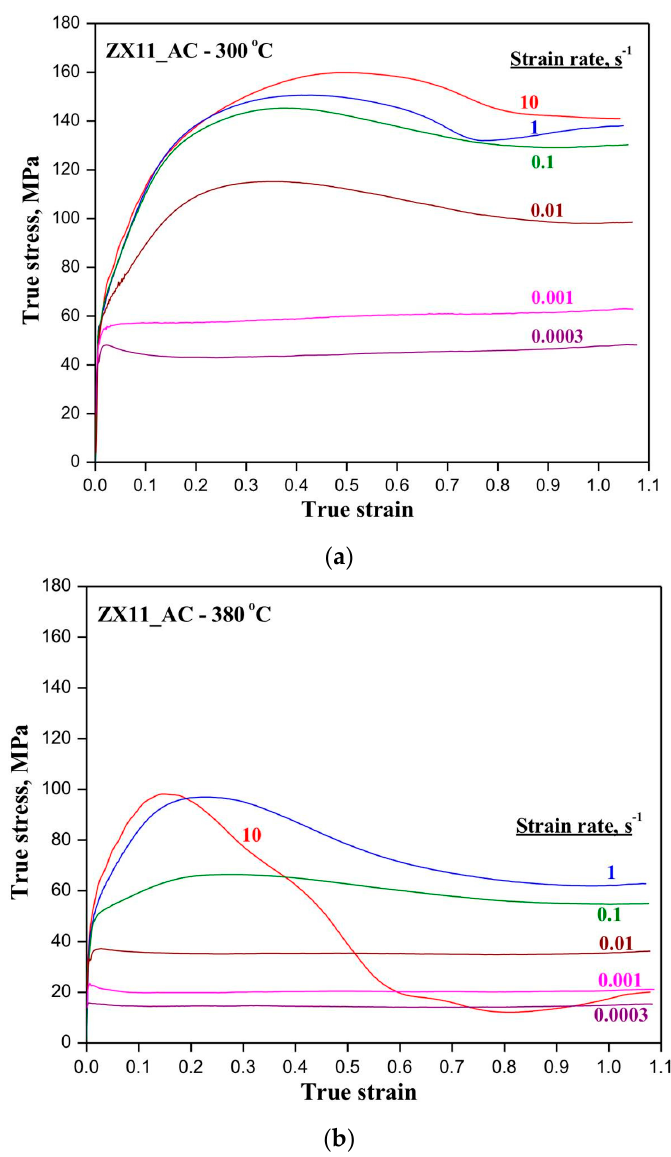
Figure 4. Flow curves obtained in compression at six strain rates: ( a ) 300 °C and ( b ) 380 °C.